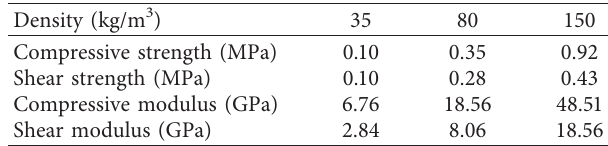
Table 2: Mechanical properties of foam